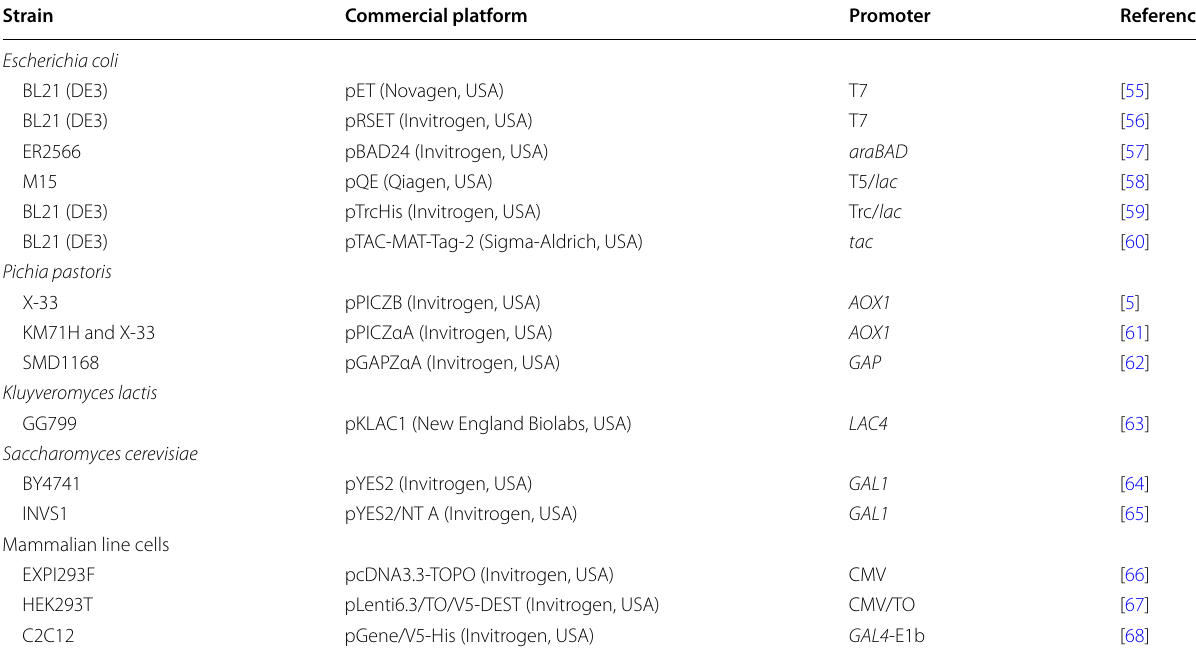
Table 1 Some commercially available platforms for Escherichia coli , yeasts, and mammalian